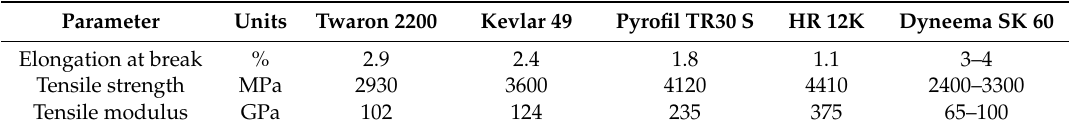
Table 2. The mechanical properties of the selected reinforcing fibers [23,30–33].